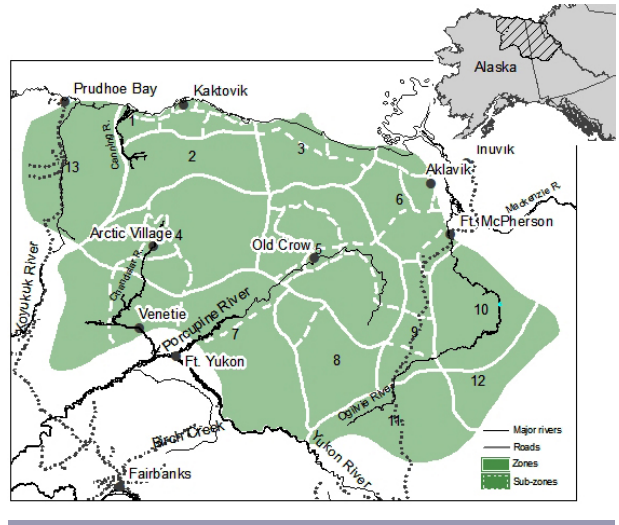
Fig. 1 . Study area: the range of the Porcupine Caribou Herd, from Kofinas and Braund (1998:14), divided into ecological movement zones (1-13) and subzones (dashed lines within